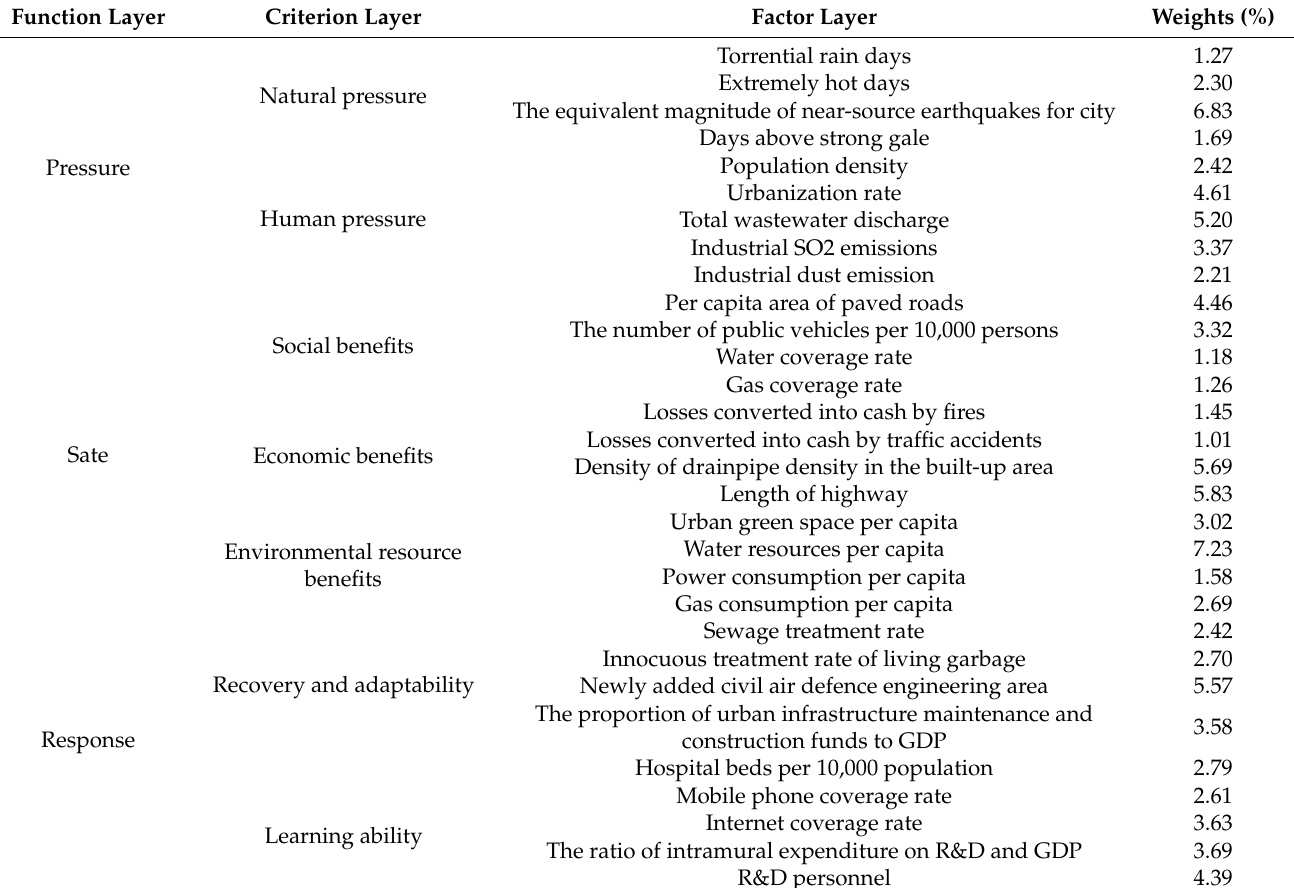
Table A1. Weights of indicator in the urban Infrastructure evaluation system.